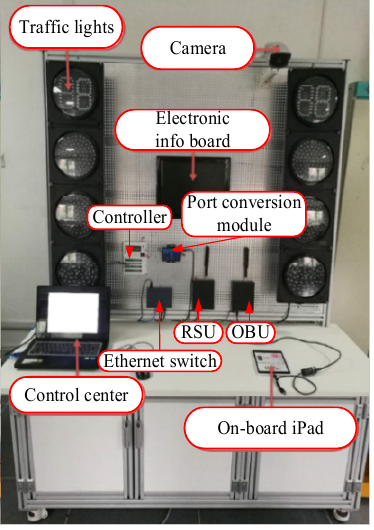
Figure 18. Parts of the indoor bench installation of the system.